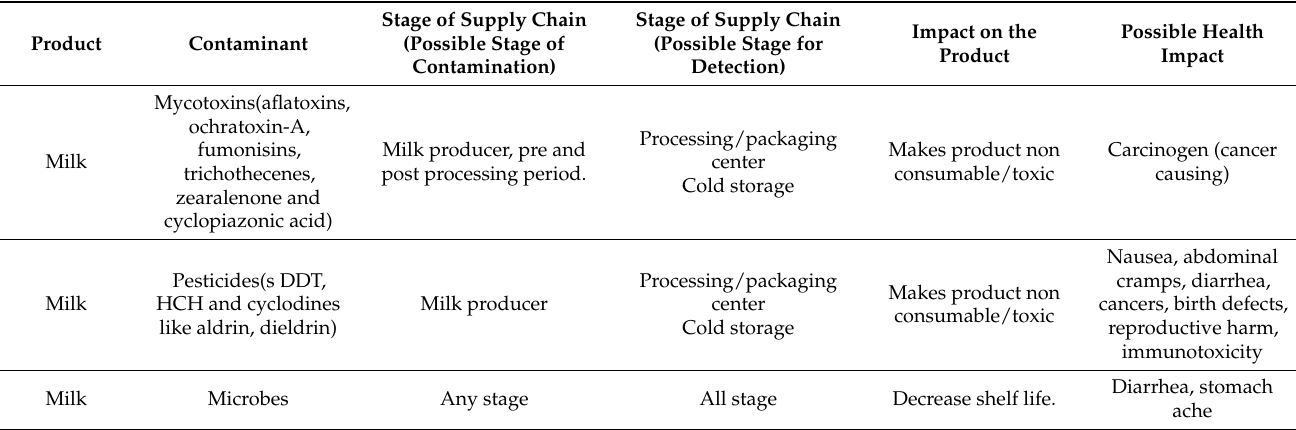
Table A4. Type of contaminants in milk and their impacts on health and nutrition.